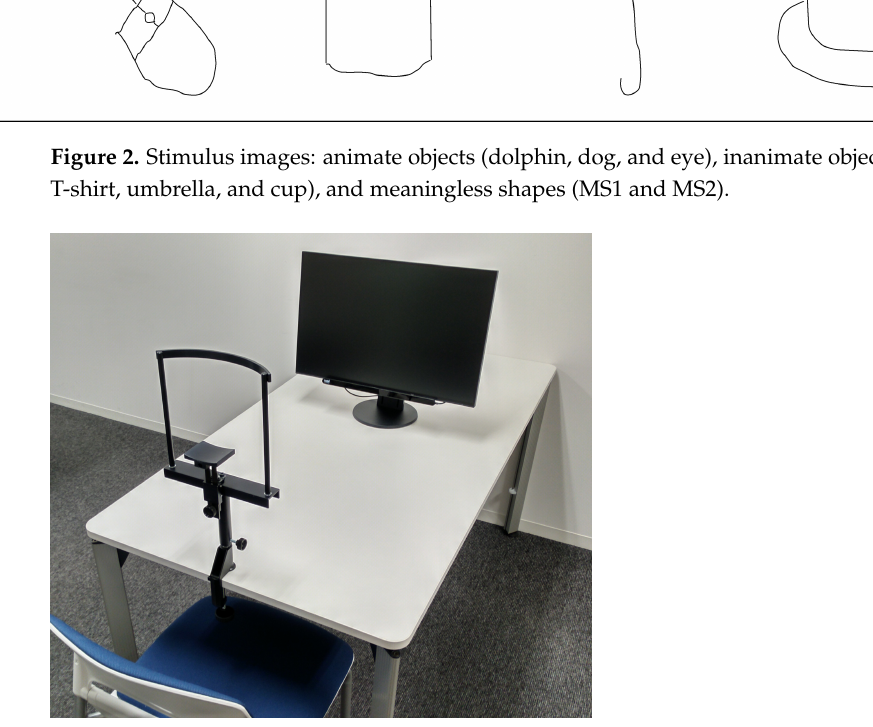
Figure 3. Experimental setup. The participants were sat in front of the display. We explained the experiment and obtained informed consent from each participant. Each participant’s chin was placed on the static chin rest. The experiment was conducted after calibrating the eye tracker according to each